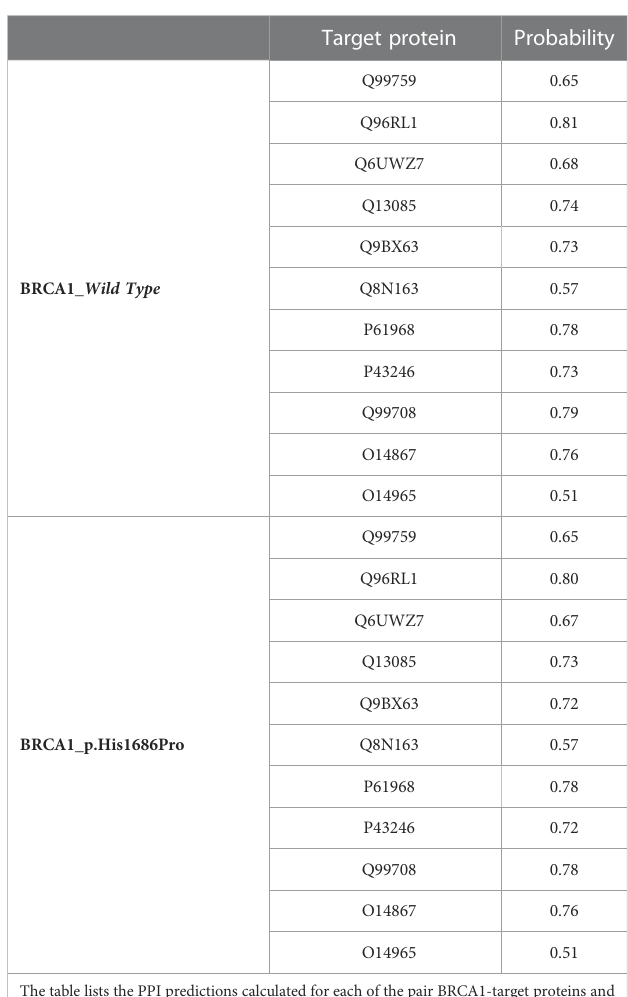
TABLE 2 Protein – protein interaction (PPI) prediction by Tri-Tool.